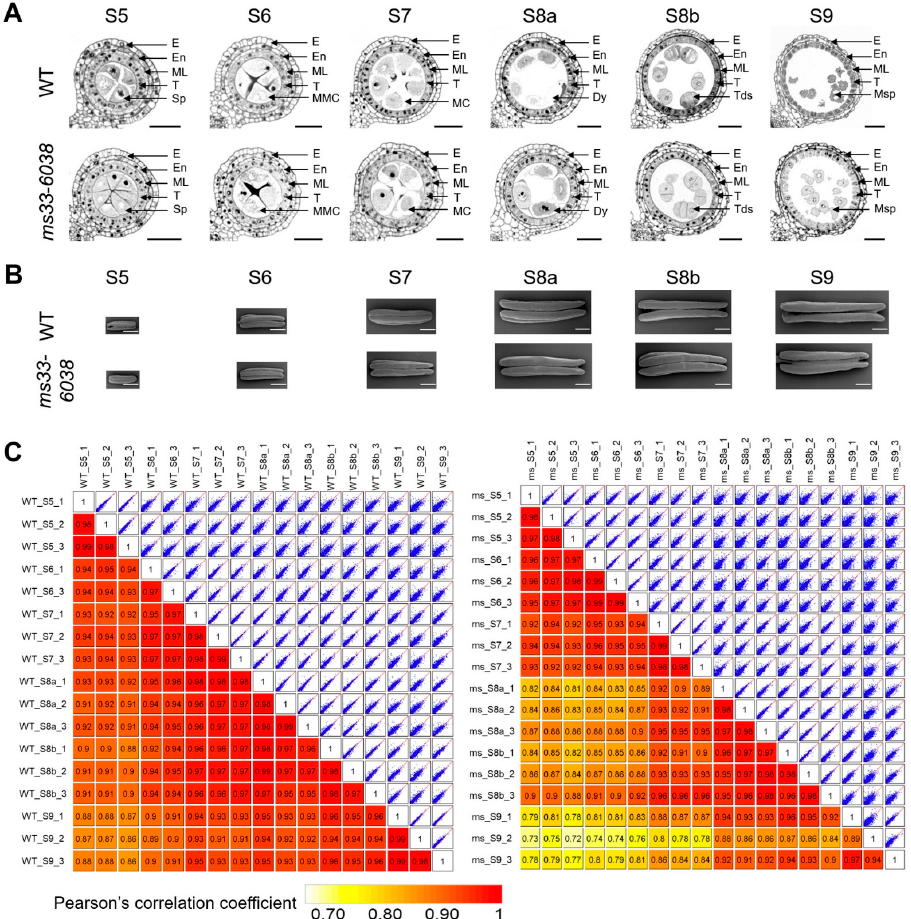
Figure 2. Sampling and the quality of RNA-seq data of WT and ms33-6038 anther transcriptomes. ( A ) Semi-thin transverse section analysis of WT and ms33-6038 anthers from stages S5 to S9. Dy, dyad; E, epidermis; En, endothecium; MC, meiocyte; ML, middle layer; MMC, microspore mother cell; Msp, microspore; Sp, sporogenous cell; T, tapetum; Tds, tetrads. Scale bars, 50 μ m. ( B ) SEM analysis of WT and ms33-6038 anthers from stages 5 to 9. Scale bars, 0.5 mm ( C ) Comparisons of the transcriptomic data of WT ( left ) and ms33-6038 ( right ) anthers at six stages. The similarity between two samples was estimated by Pearson’s correlation coefficient.